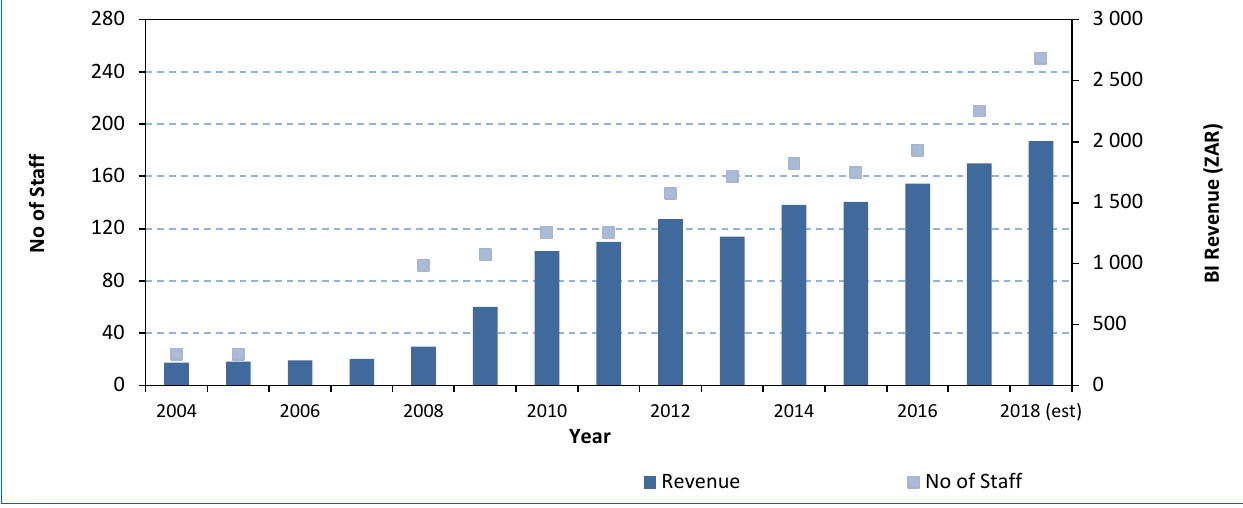
Figure 2. Growth of the Biovac Institute (2004 to